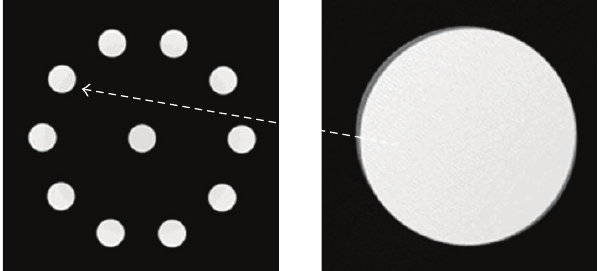
Figure 5: Reconstruction images from the translated projection data, or CT image artifact caused by the deflection of linear detectors. 𝑥 2 𝑆